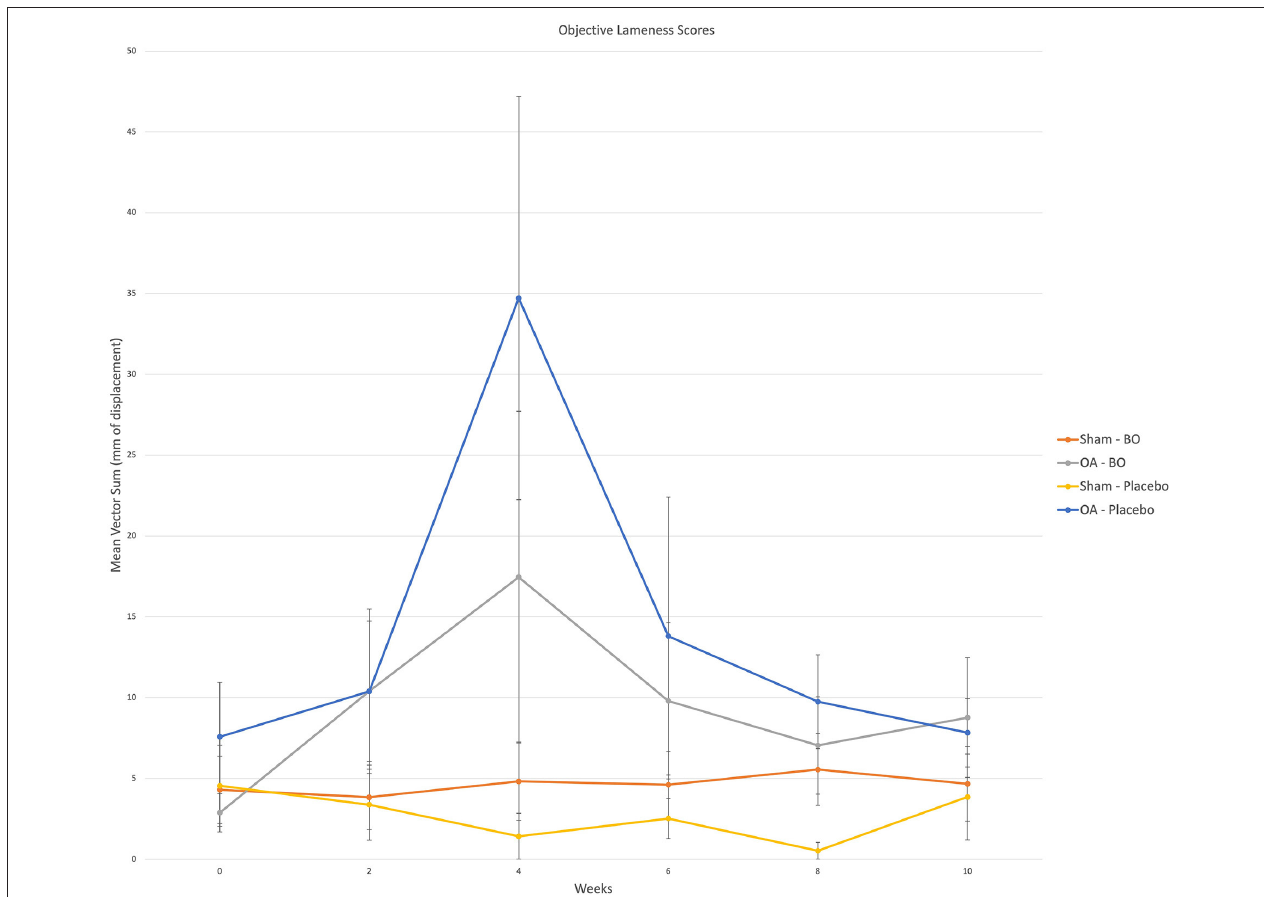
FIGURE 3 | Objective lameness scores were obtained via an inertial sensor system on weeks 0, 2, 4, 6, 8 and 10. A single fore signed vector sum was assigned to each horse for which a positive value represented a right front lameness and a negative value represented a left front lameness. The value represents a magnitude of lameness in the form of millimeters of displacement. For analysis the ( + ) and (-) were removed as the values were assigned to the specific limb; i.e., OA limb of horses receiving the treatment (OA-BO), sham operated limb of horses receiving the treatment (Sham-BO), OA limb of horses receiving the control (OA-Placebo) and sham operated limb of horses receiving the control (Sham-Placebo). This data represents mean ( + /- SEM) from raw data and not the data upon which the statistics were run thereby a p -value does not correlate with the data presented